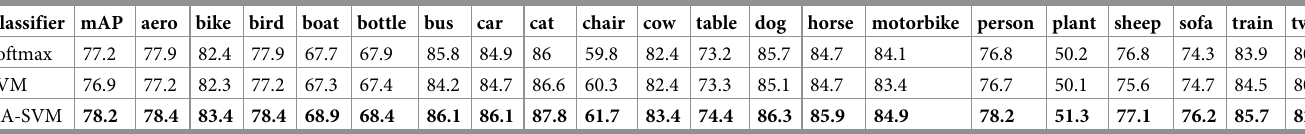
Table 11. Comparison between the softmax, SVM and GA-SVM classifiers.